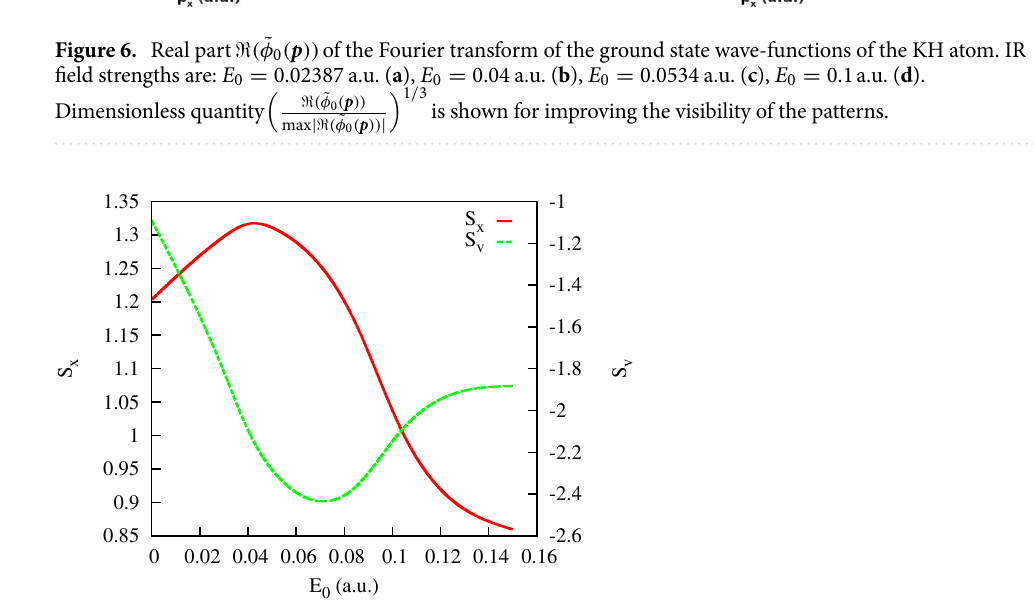
Figure 7. Entropies of the coordinate and momenta distributions for the KH ground